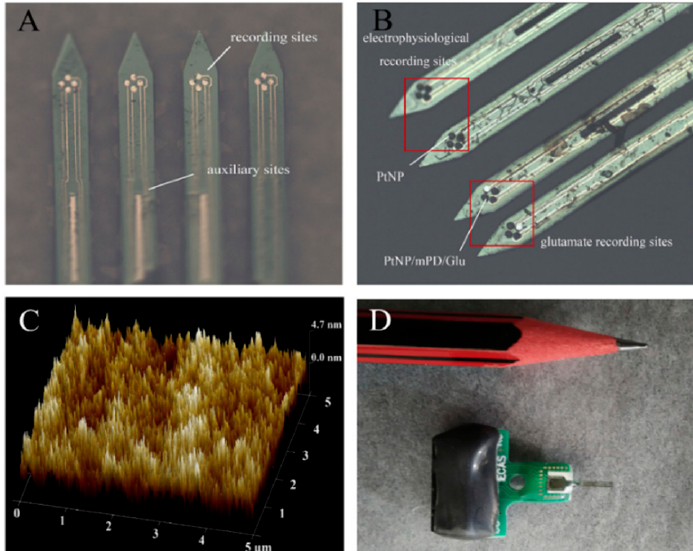
Figure 4. Structure and modification of microelectrode array (MEA). ( A ) Silicon-based MEA with four shafts [92]. The 16 round sites were used as recording sites to detect electrophysiological and electrochemical signals, and the three rectangular sites were used as auxiliary sites in the three-electrode system. ( B ) The electrophysiological recording sites are modified with PtNP and glutamate recording sites have three different layers (PtNP/mPD/Gluox) modification. The thicknesses of PtNP layer and the enzyme layer were 3.2 and 1.5 µ m, respectively. ( C ) The AFM photograph of the surface of Gluox enzyme layer. Surface irregularities make Gluox more accessible to glutamate. ( D ) The physical view after package, the size of this sensor is close to the pencil head and the weigh is about 1 g [68]. (Reproduced here with copyright permission